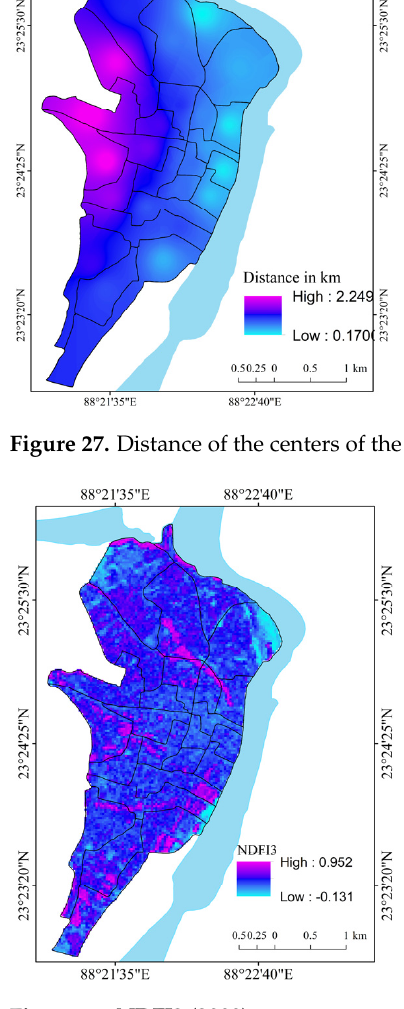
Figure 29. Relief (2015). Figure 30. Slope (2015).